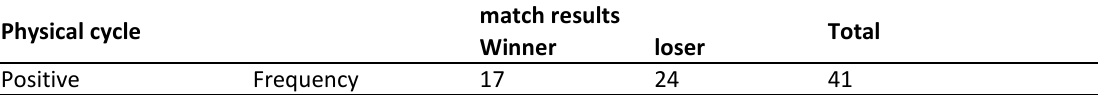
Table 4. Relationship between match results with different levels physical cycle Physical